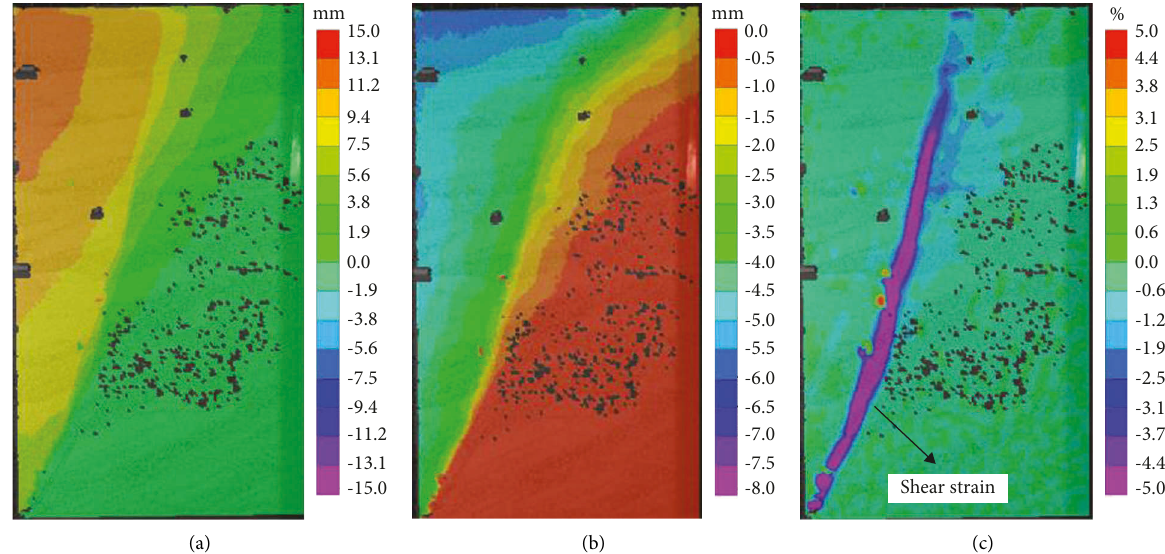
Figure 6: The ground displacement in sample M0; (a) the vertical settlement, (b) the horizontal displacement, and (c) the shear strain.